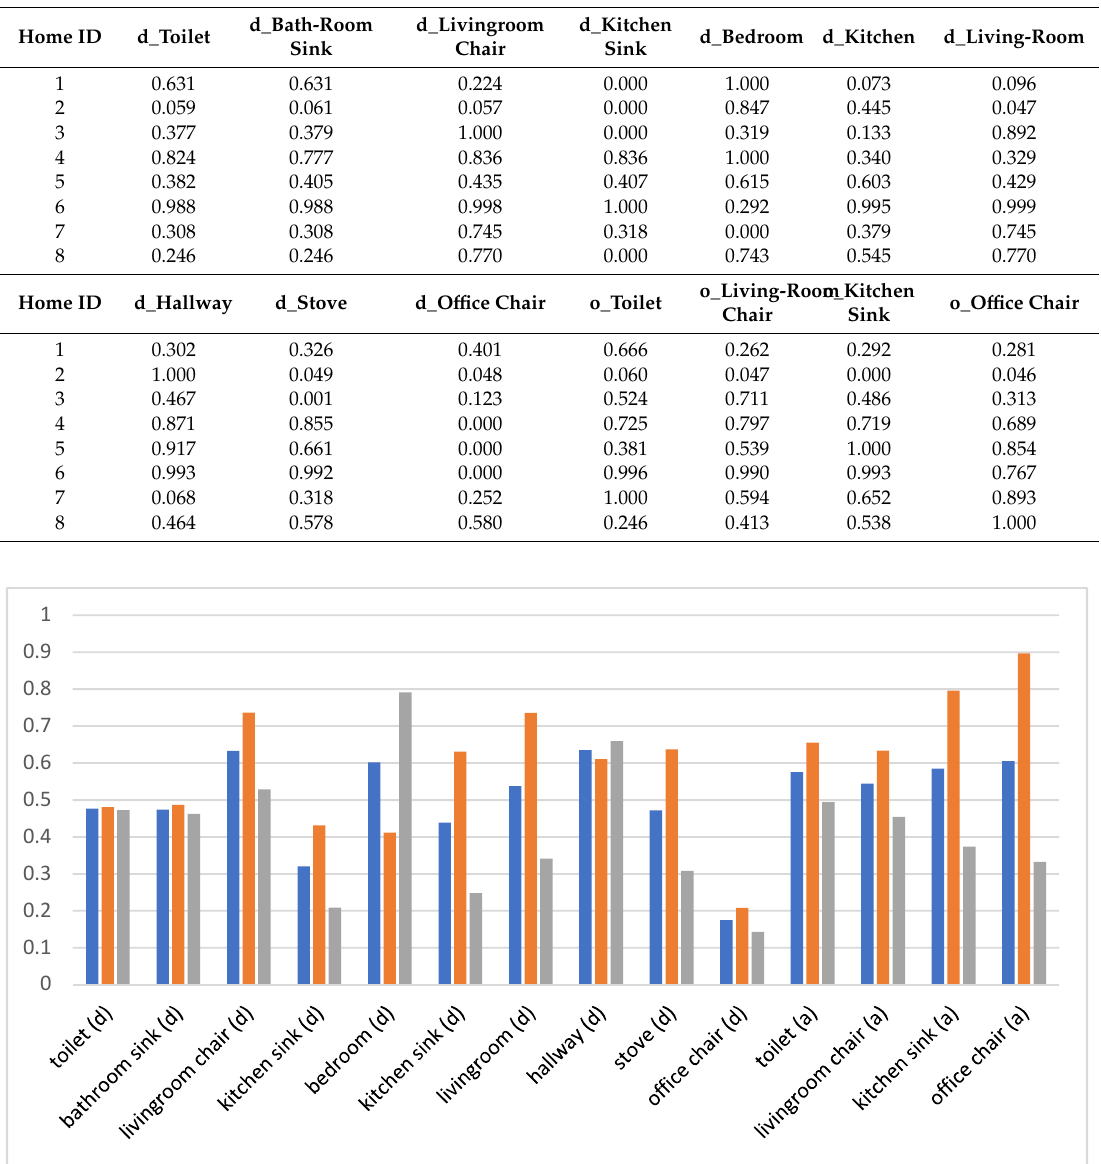
Table 4. Smart home normalized preference vectors.